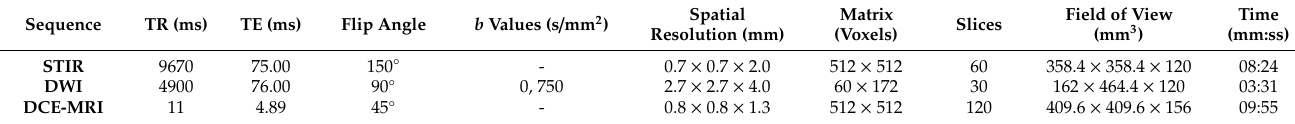
Table 1. Breast magnetic resonance technical parameters for each acquired sequence.